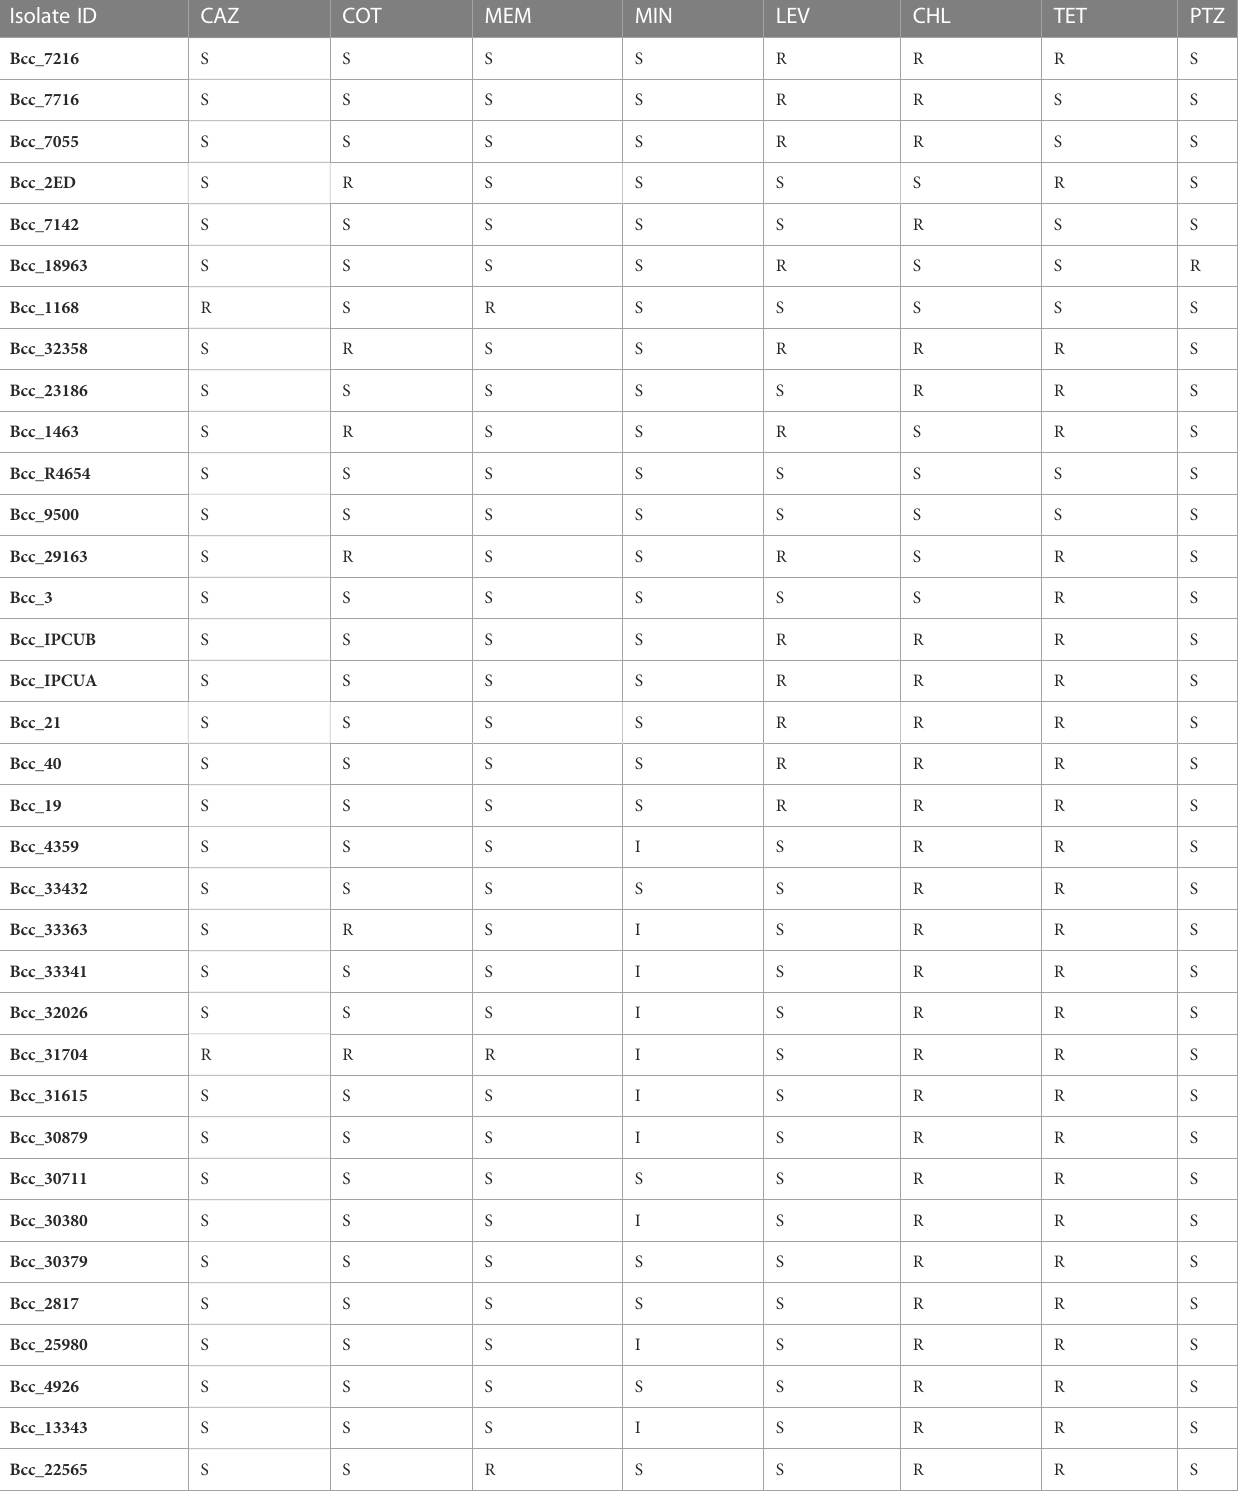
TABLE 1 Antimicrobial susceptibility testing of 35 CC31 isolates from India. Isolate